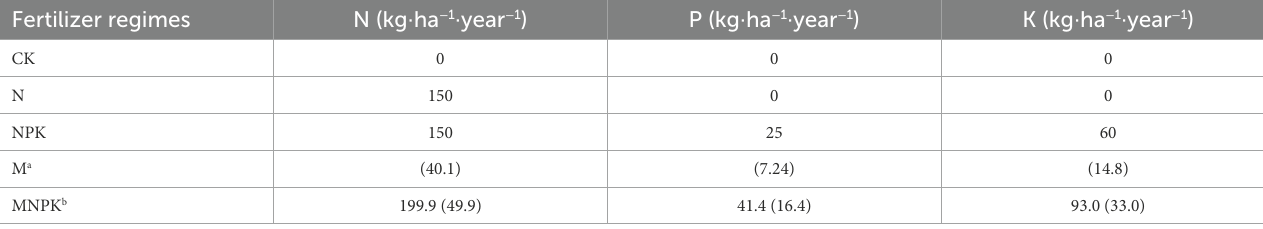
TABLE 1 Experimental design and nutrient inputs of selected treatments in 2018. Fertilizer